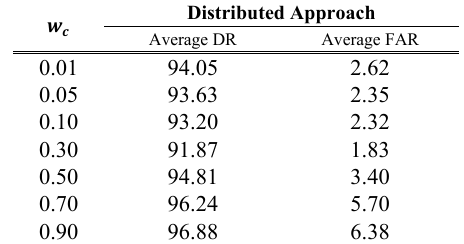
Table 2. Average detection and false alarm rates of the distributed approach for different values of (cid:2205) (cid:2185) (cid:2205)